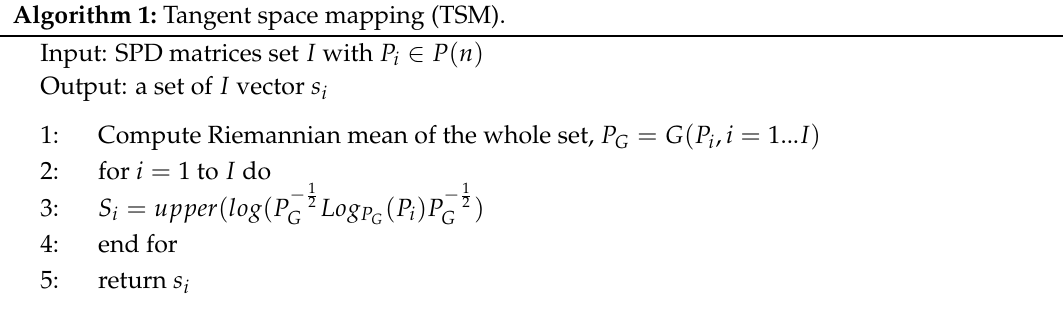
Algorithm 1: Tangent space mapping